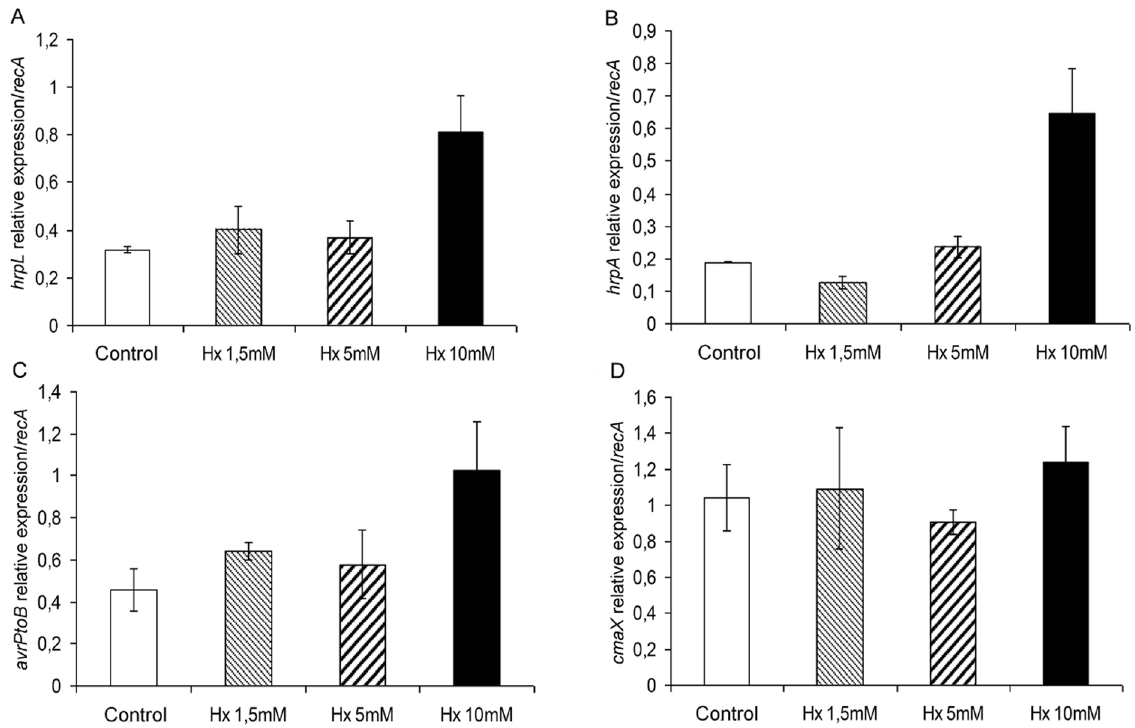
Figure 5. Expression of type III secretion system- and other virulence factor-related genes in response to different hexanoic acid concentrations. The transcript levels of hrpL (A), hrpA (B), avrPtoB (C), and cmaX (D) were examined as described in Figure 3, and the recA gene was used as an internal reference. The results represent the means and standard deviation from three different experiments.